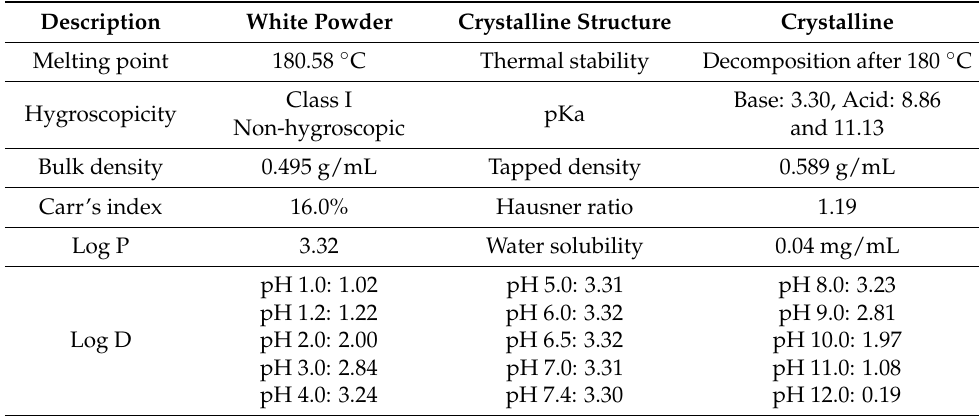
Table 1. Physicochemical properties of JIN-001 by experimental